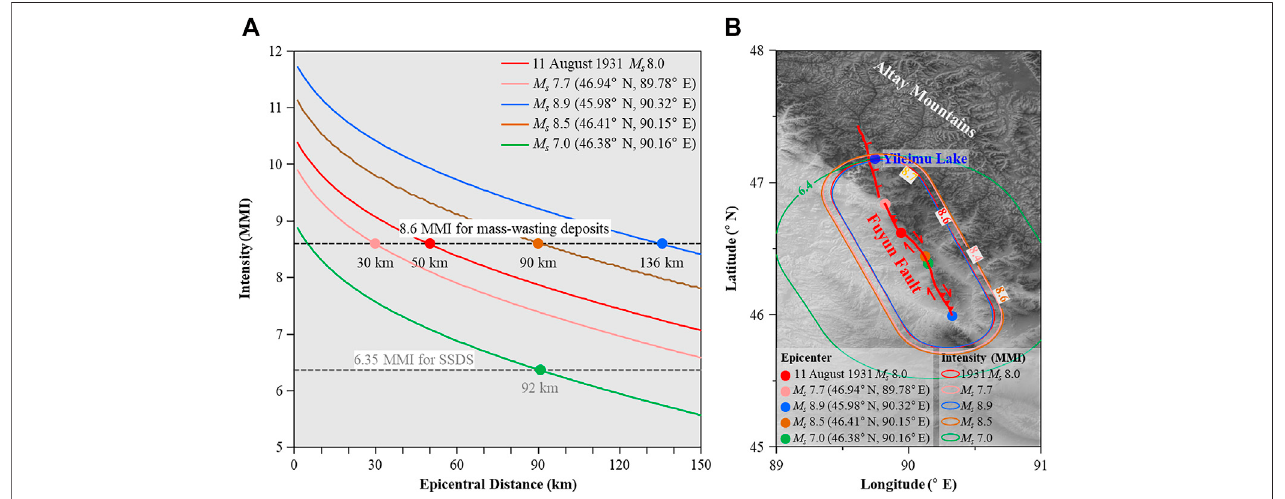
FIGURE 8 | (A) Shaking intensity variations with epicentral distance and (B) calibrated isoseismal modelling results for different magnitudes of earthquakes from different sites along the Fuyun Fault. The pink, red, brown, blue and green circles in (A,B) are in one-to-one correspondence. The intensity prediction equations (IPEs) used in (A,B) are from Wang et al. (2000), and Dowrick and Rhoades (2005), respectively. MMI, Modi fi ed Mercalli